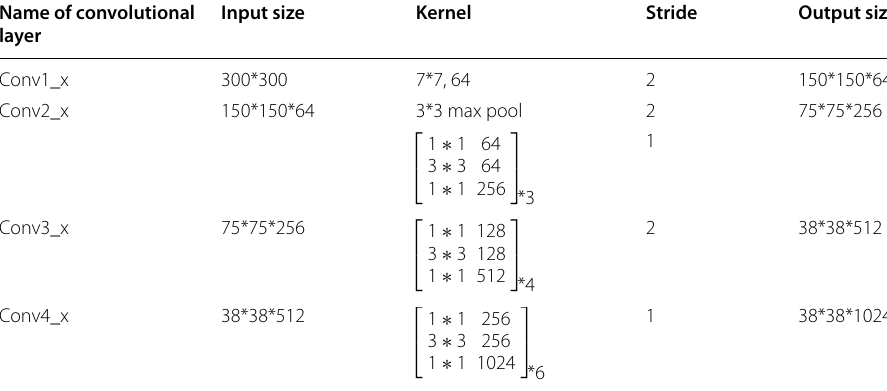
Table 2 Backbone network parameters after modification Name of convolutional